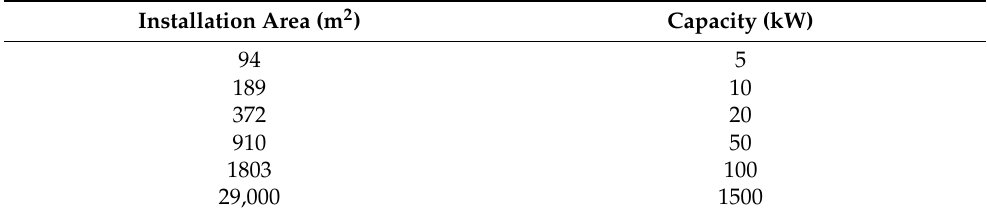
Table 6. Photovoltaic capacity